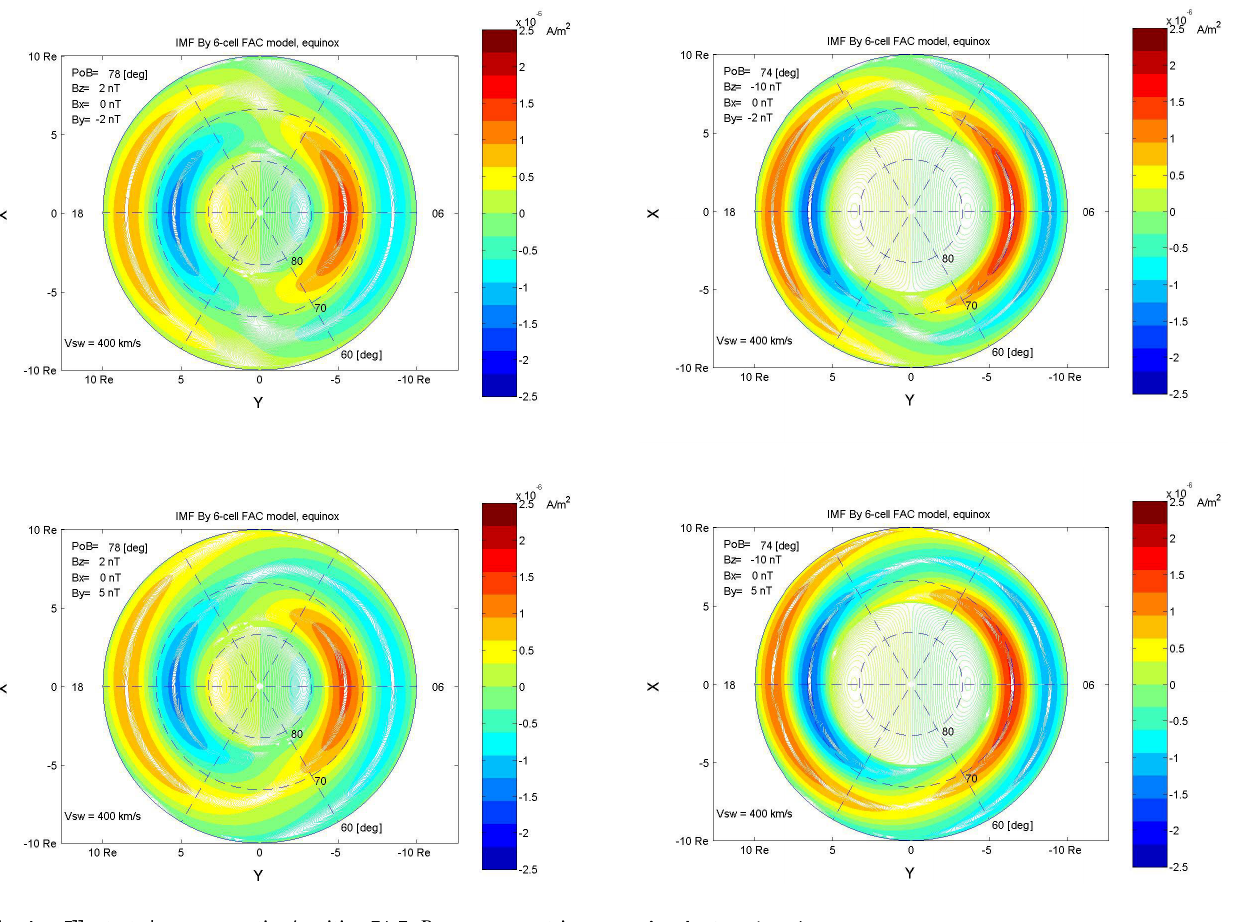
Fig. 4a. Illustrate how a negative/positive IMF B y component in- fluences the SW mode FAC structure. During positive IMF B y , the Region 1 system from the dawn sector is extended across the noon sector. On the other hand, the Region 1 system from the dusk sector (of inverse polarity) continues into the Region 2 system from the dawn sector. When the IMF B y module well exceeds 2nT, the six- cell FAC structure evolve into two FAC “spirals” of inverse polarity. When the IMF B y component reverses its sign, the sense of the FAC “spirals” also reverses. In the midnight sector the dawn (dusk) Re- gion 1 structure goes continuously to the dusk (dawn) Region 2 cell. The IMF B z component is set to − 10, 2 and 10nT. Figure 4b is for IMF B z =− 10nT, and 4c – for IMF B z